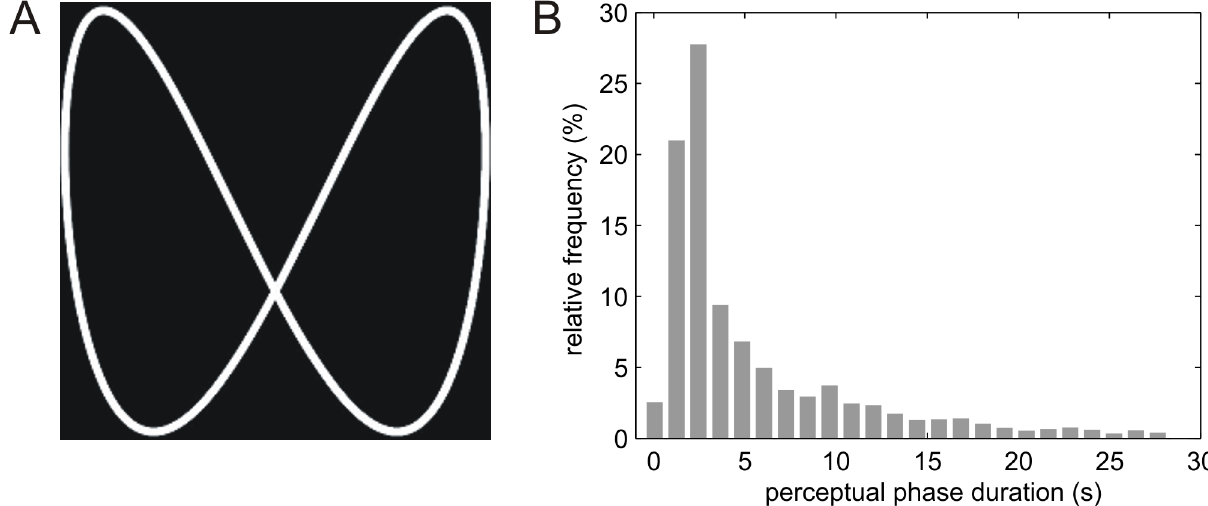
Fig 1. Lissajous figure and distribution of perceptual phase durations. (A) Lissajous are generated by the intersection of two sinusoids with perpendicular axes and increasing phase-shift whose frequency determines the speed of illusory 3D rotation. Following their introduction to experimental psychology, Lissajous figures were originally studied by means of twin-oscillators and analog cathode ray oscillographs in the 1940s and 1950s [6]. (B) Perceptual phase duration across all participants, runs and conditions. Distributions with a sharp rise and a long tail are typical of bistable